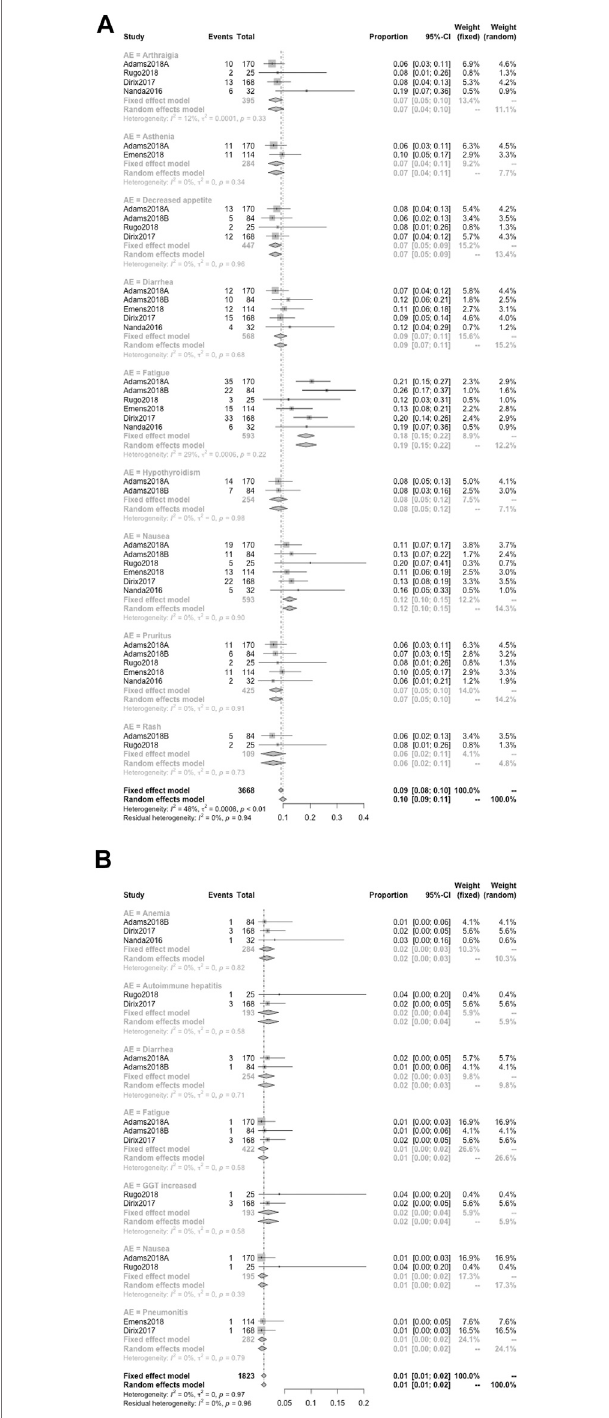
FIGURE6| Detailedincidenceoftreatment-relatedAEsinanygrade (A) and in severe grade (B) . When the speci fi c AEs reported in at least two studies were analyzed, treatment-related AEs of any grade that occurred in at least 5% of patients were fatigue (18%), nausea (12%), diarrhea (9%), hypothyroidism (8%), arthralgia (7%), asthenia (7%), decreased appetite (7%), pruritus (7%), and rash(6%) (A) ;treatment-relatedAEsofseveregradethatoccurredinatleast1%of patientswereanemia(2%),autoimmunehepatitis(2%),diarrhea(2%),fatigue(1%), GGT increased (2%), nausea (1%), and pneumonitis (1%) (B) .